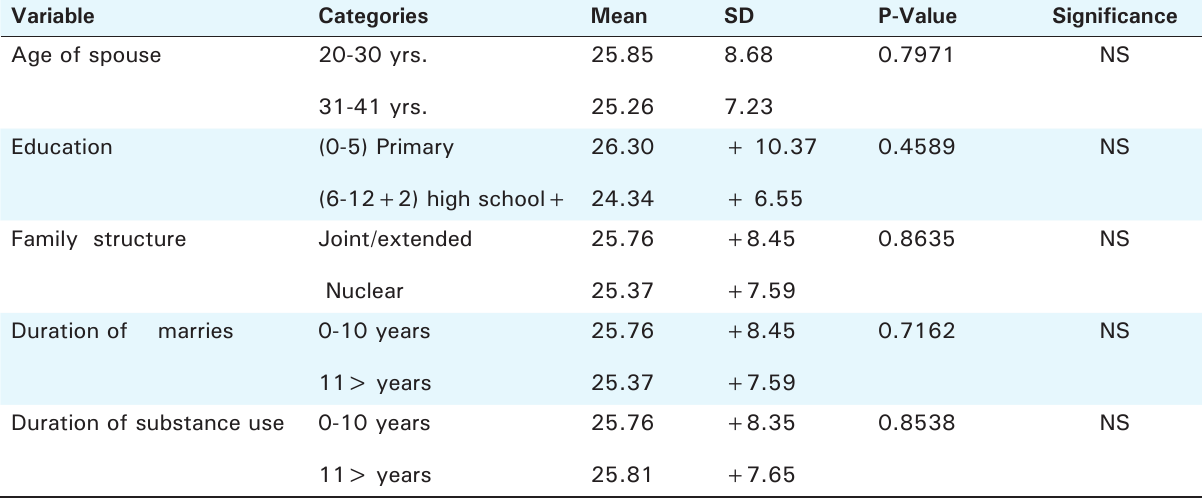
Table 7. Relationship between spouses’ perceived family burden (total) and their socio-demographic variables (n=50)